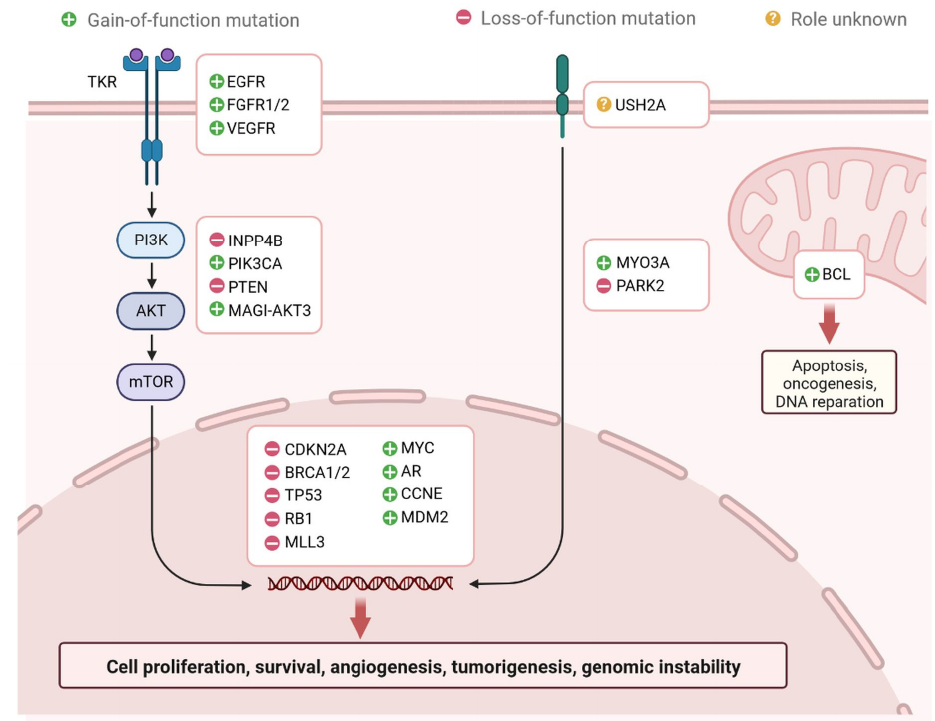
Figure 2. Regulation of genetic markers associated with TNBC . Genetic markers associated with gain of function: EGFR, EGFR1/2, VEGFR, MYC, AR, CCNE, MDM2, PIK3CA, MAGI-AKT3, MYO3A, and PARK2. Genetic markers associated with Loss of function: INPP4B, PTEN, CDKN2A, BRCA1/2, TP53, RB1, and MLL3.